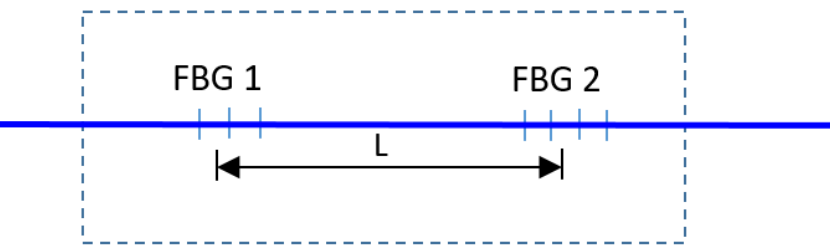
Figure 1. Schematic of the fiber optic sensor.